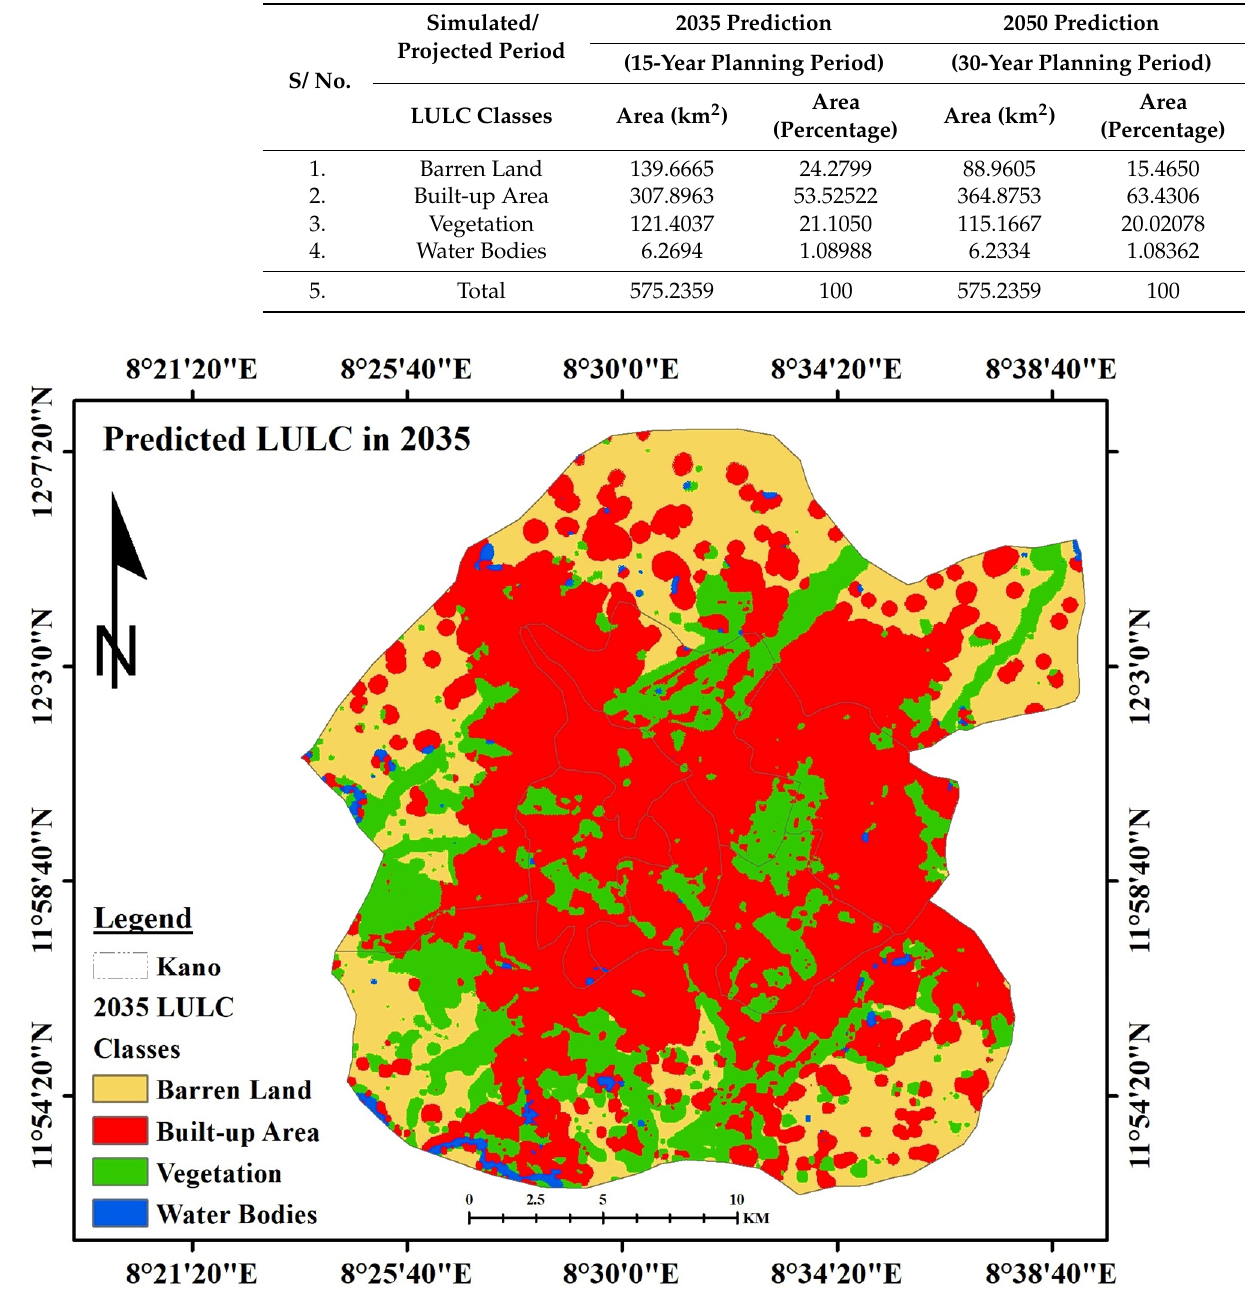
Table 6. Statistical data of the predicted LULC in 2035 and 2050.